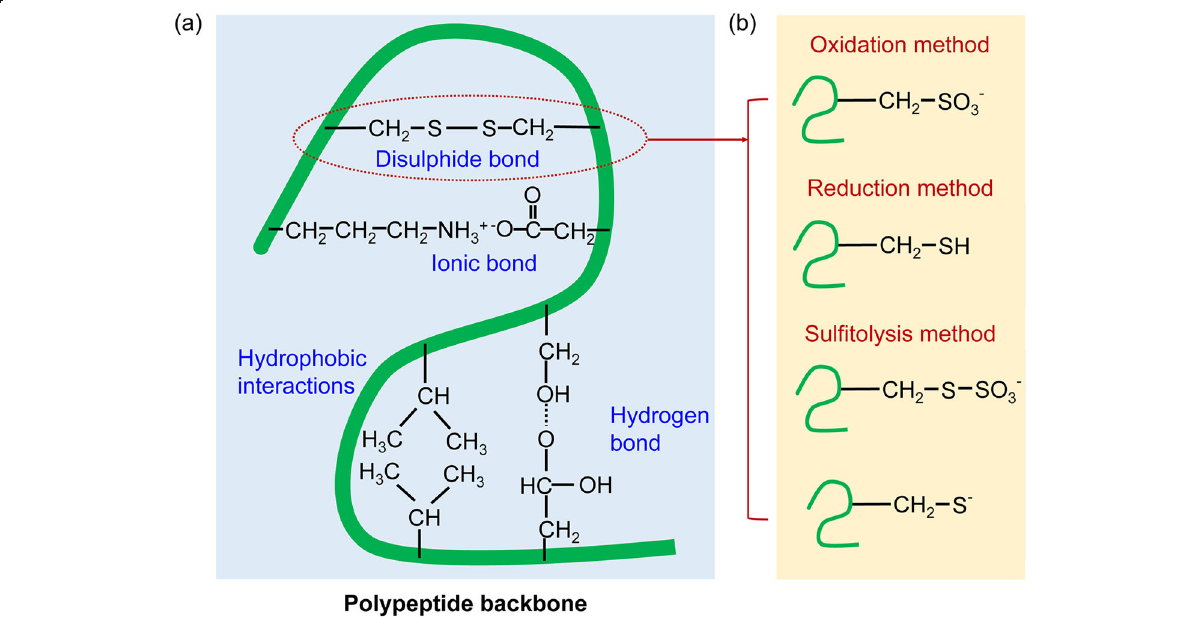
Fig. 3 ( a ) Schematic diagrams of inter-molecular and intra-molecular bonding of keratin; ( b ) Keratin extraction mechanism by oxidation method, reduction method, and sulfitolysis method,